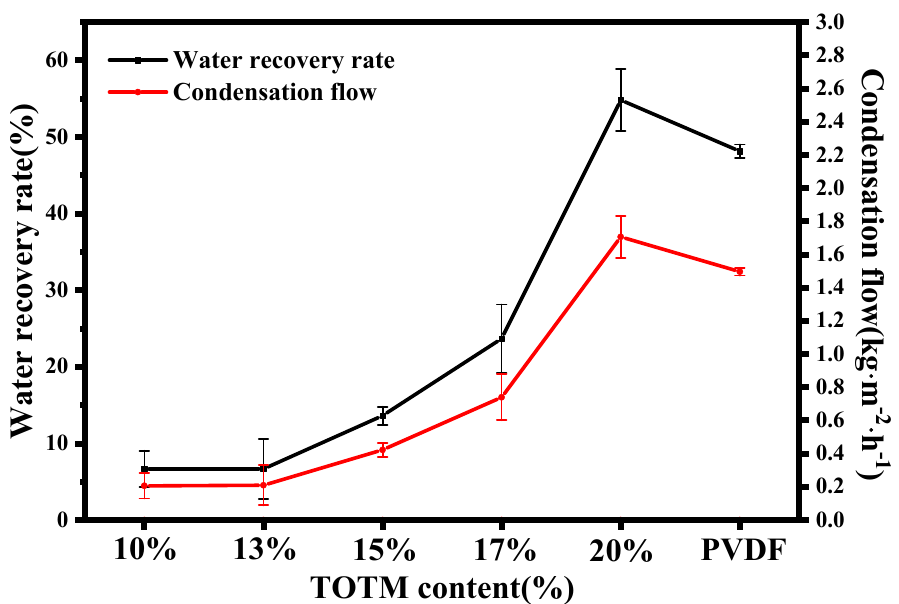
Figure 9. MC performance of ECTFE membranes prepared with different TOTM contents.